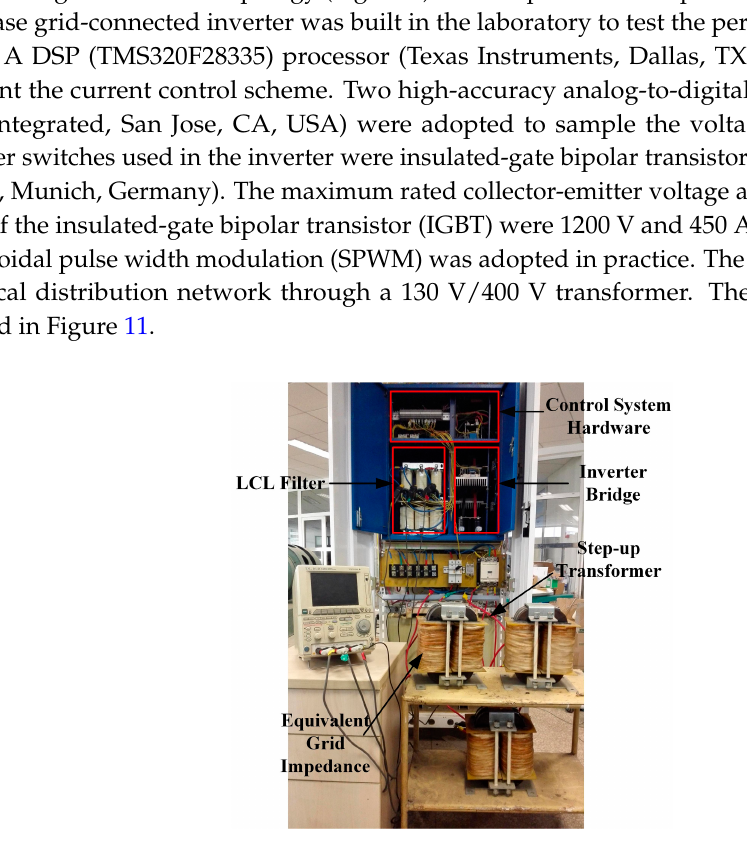
Table 2. Parameters of the Current Control Scheme